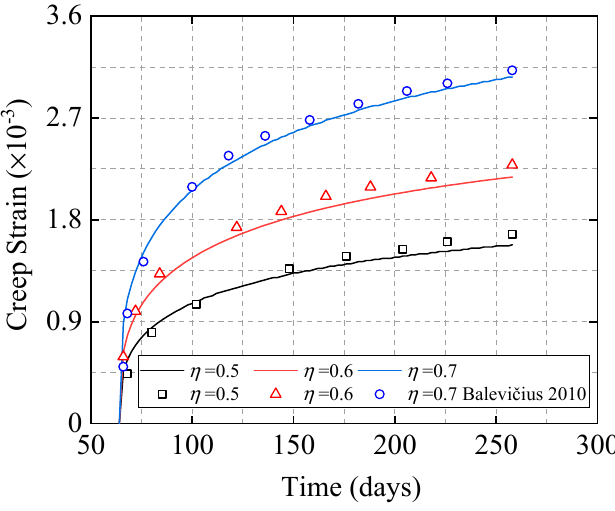
Figure 10. Creep strain test results [37] and formula predictions at gradient stress level of 0.5~07. Figure 9. Comparative analysis of amplification factor compared with Tang [21] and Balevi č ius [42].